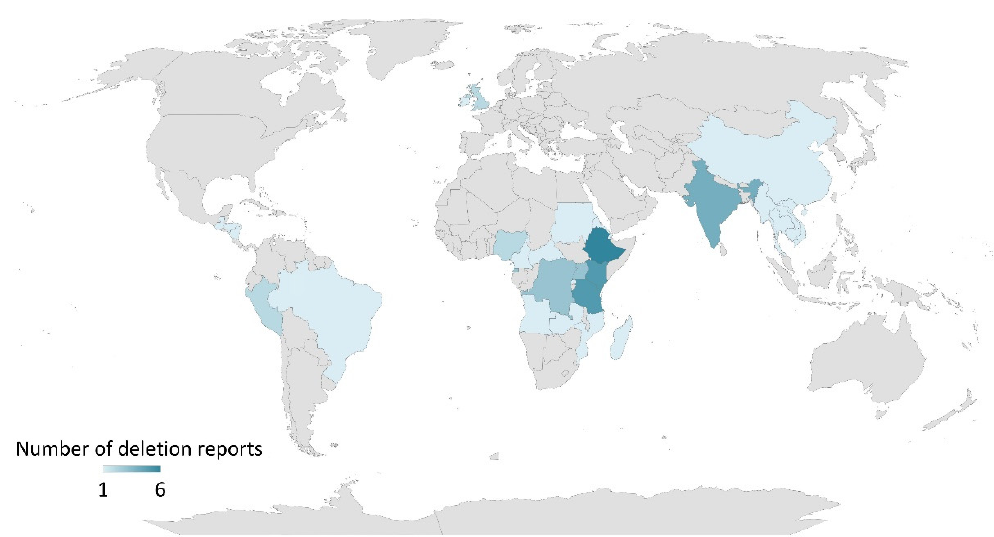
Figure 1. Reports on pfhrp2/3 deletions by country, 2018–2022. The map was created using